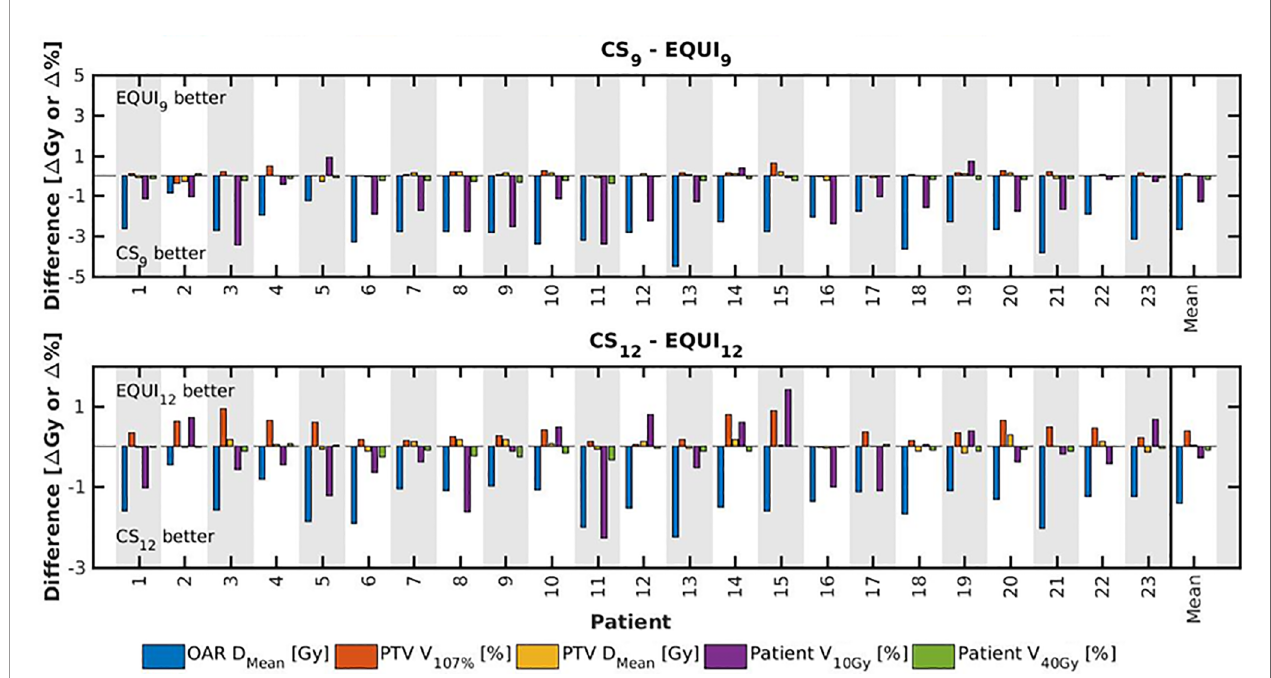
FIGURE 7 | For all patients separately, plan parameter differences between CS x and EQUI x for x=9 and x=12. The las columns show population mean